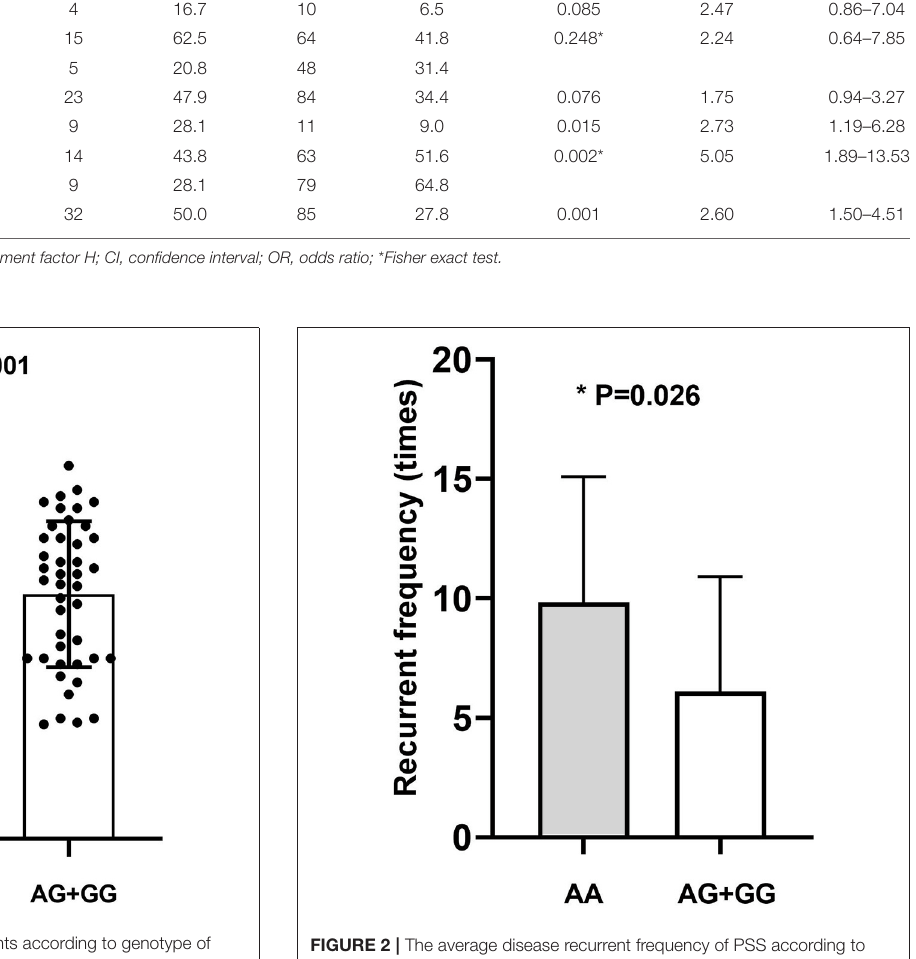
FIGURE 2 | The average disease recurrent frequency of PSS according to genotype. AA: 9.83 ± 5.25; AG + GG: 6.11 ± 4.81 (times). *statistical